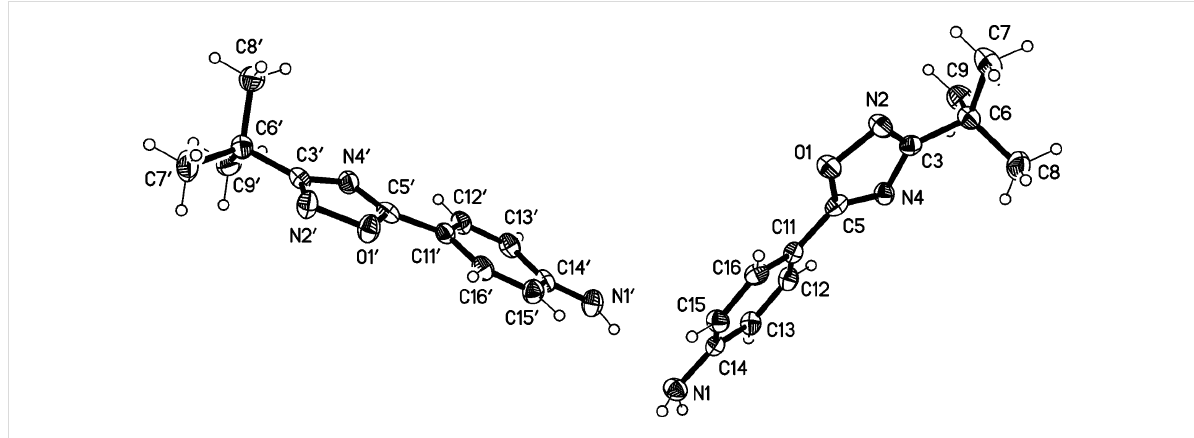
Figure 3: Molecular structure of 4-(3- tert -butyl-1,2,4-oxadiazol-5-yl)aniline ( 1 ). Atoms are drawn as 50% thermal ellipsoids. One hydrogen at N1’ is eclipsed.